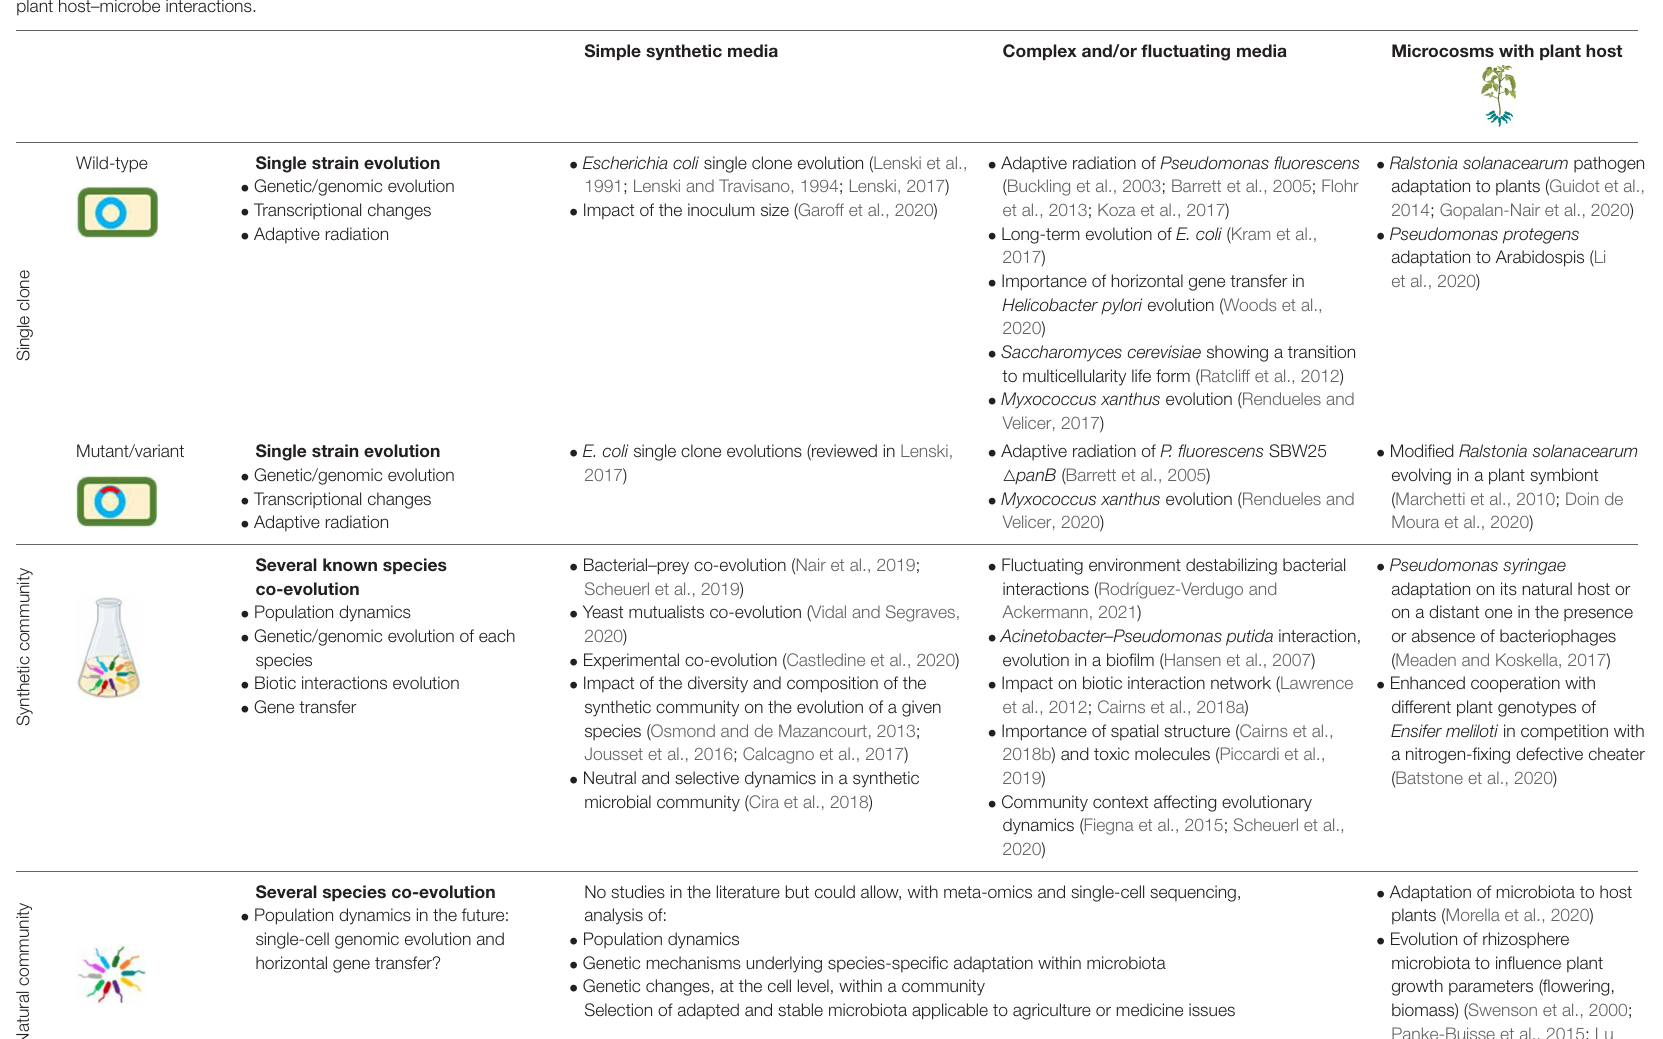
TABLE 1 | Selected examples of experimental evolution studies (with a focus on interactions with plants at the microcosm scale), that have contributed to advances in genomic evolution, horizontal gene transfer, and plant host–microbe